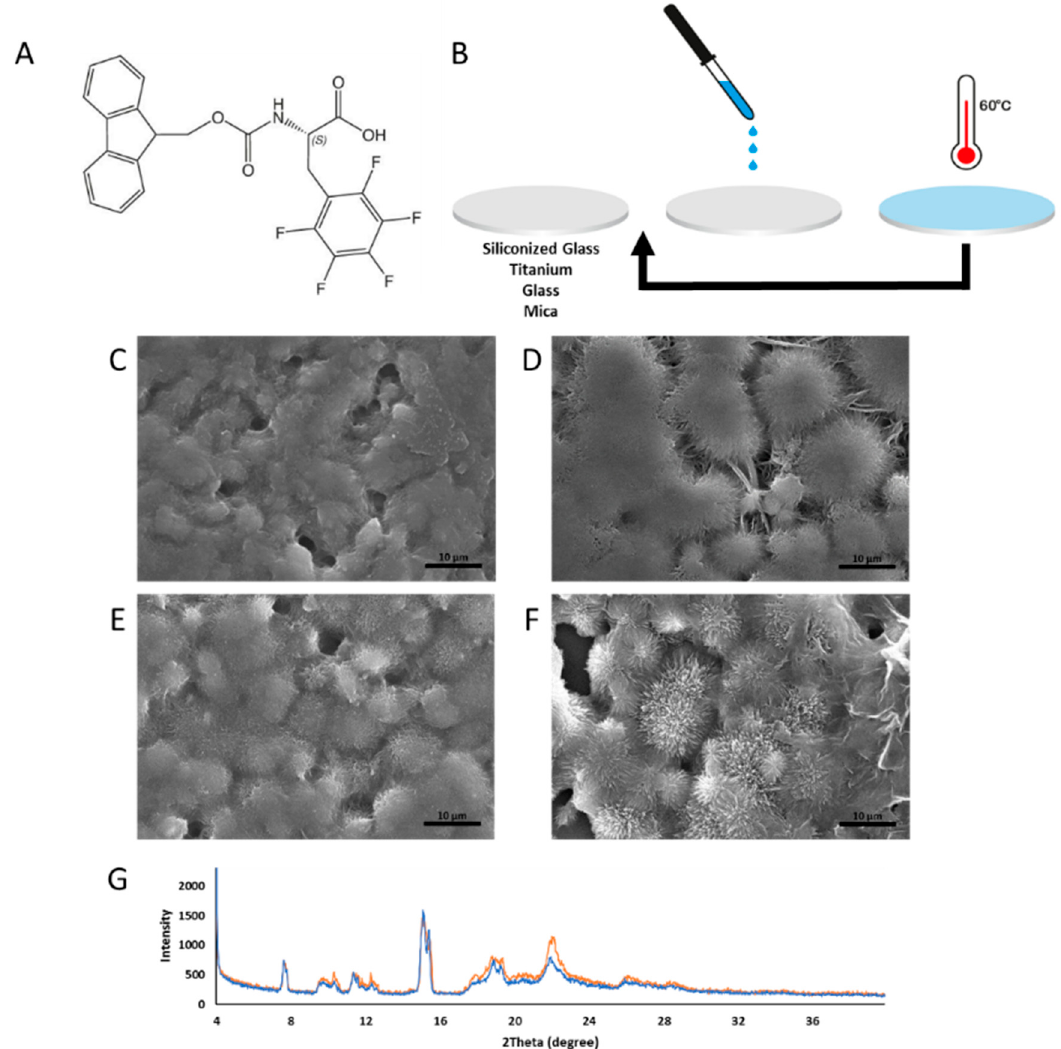
Figure 1. Characterization of the Fmoc-F 5 -Phe coating. ( A ) Molecular structure of the modified amino acid Fmoc-F 5 -Phe. ( B ) Schematic illustration of the modified drop-cast technique for surface coating of siliconized glass, titanium, glass and mica surfaces. The arrow represents the repetition of the drop-casting process and heating of the stages. ( C , D ) SEM structural characterization of Fmoc-F 5 -Phe-coated ( C ) titanium surface and ( D ) siliconized glass surface before stability test. ( E , F ) SEM structural characterization of Fmoc-F 5 -Phe-coated ( E ) titanium and ( F ) siliconized glass after stability test (Scale bar 10 µm). ( G ) XRD structural analysis of Fmoc-F 5 -Phe-coated glass surface before (orange) and after (blue) stability test.